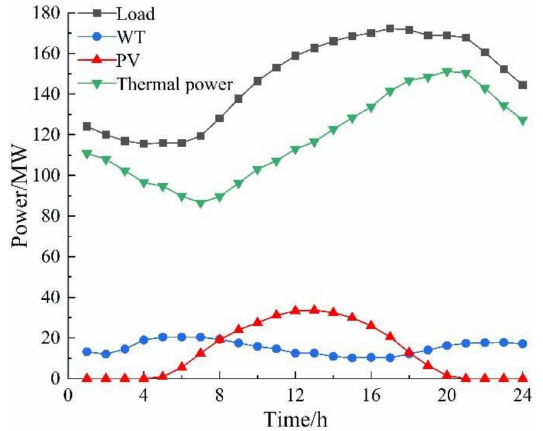
Figure 17. Typical daily power curve for scenario